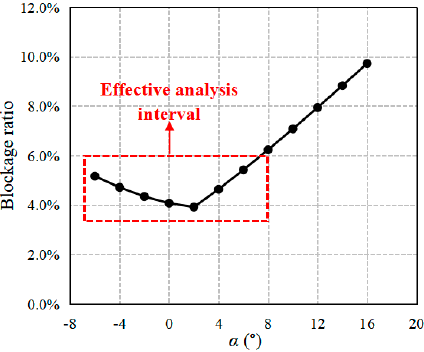
Figure 4. Change of blockage ratio with angle.